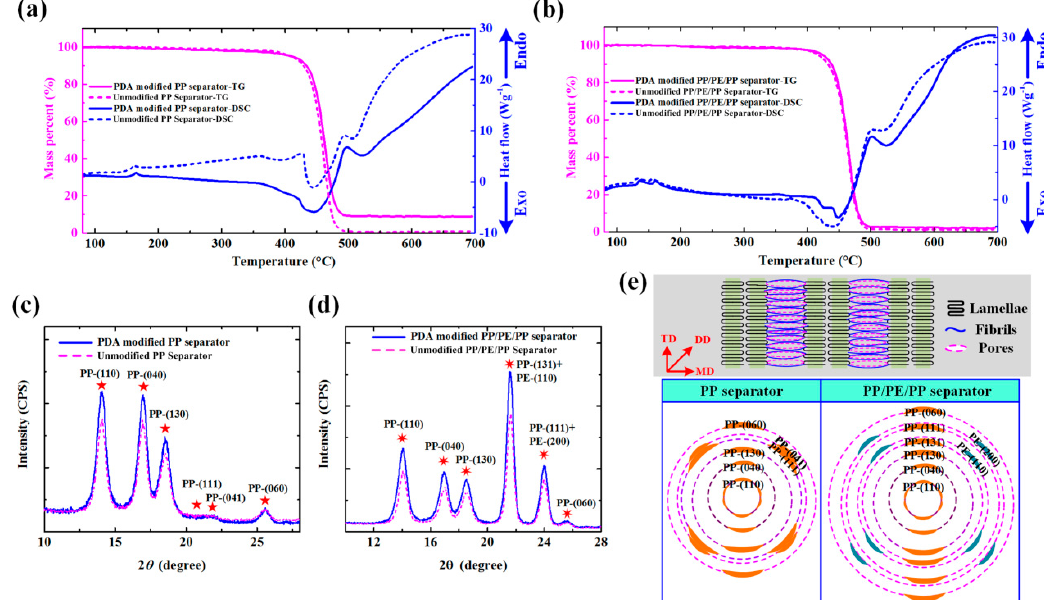
Figure 5. Characterizations of unmodified and PDA-modified separators: (a,b) Thermogravimetric (TG) and differential scanning calorimetric (DSC) curves of unmodified PP, PDA-modified PP, unmodified PP/PE/PP, and PDA-modified PP/PE/PP separators; (c,d) X-ray diffractometer (XRD) spectra of unmodified PP, PDA-modified PP, unmodified PP/PE/PP, and PDA-modified PP/PE/PP separators; (e) diffraction schematic diagram of lattice plane distributions of the PP separator indicated by PP-(110), PP-(040), PP-(130), PP-(111), PP-(041), and PP-(060) and the PP/PE/PP separator indicated by PP-(110), PP-(040), PP-(130), PP-(131)+PE-(110), PP-(111)+PE-(200), and PP-(060).